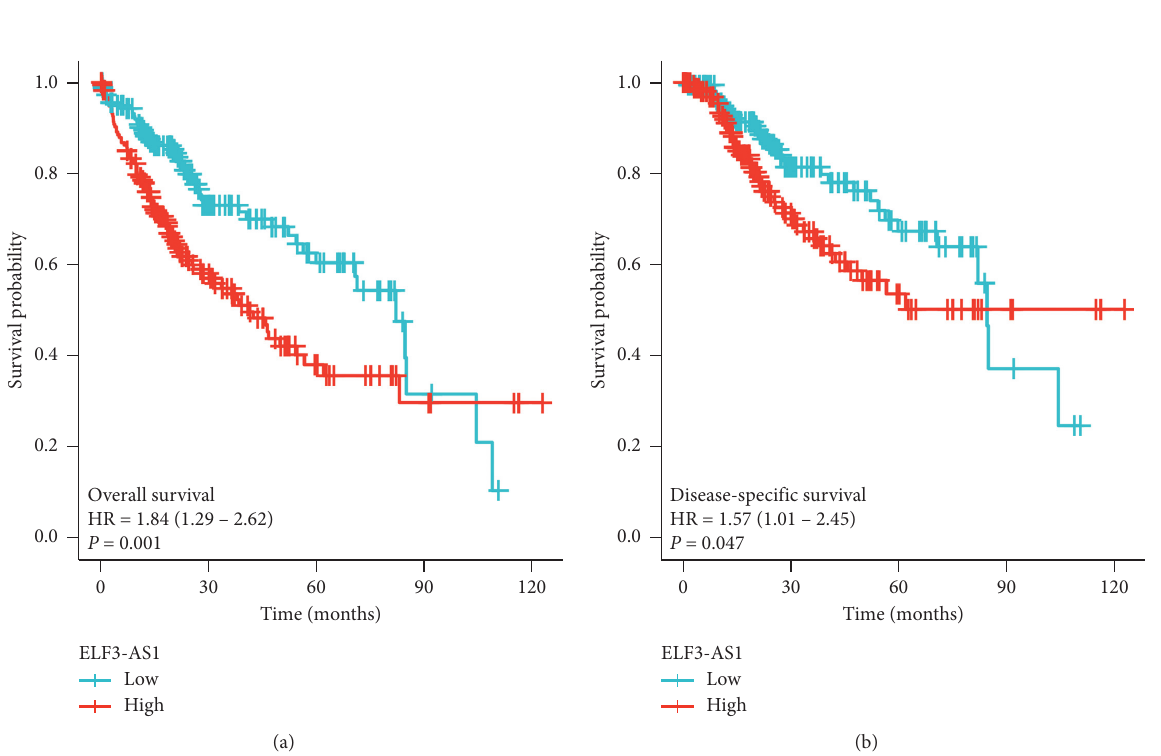
Figure 3: Low ELF3-AS1 expression was associated with poor OS and DSS in patients with HCC. (a) Over survival. (b) Disease Specific